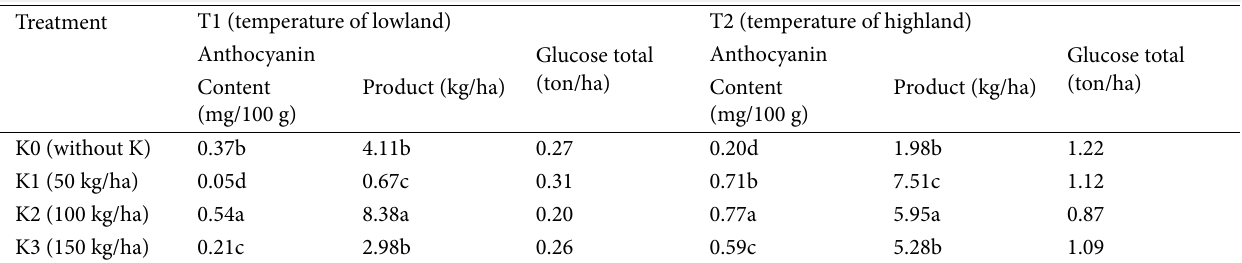
Table 5 Differences in biochemical component caused by the interaction of temperature and potassium treatment at